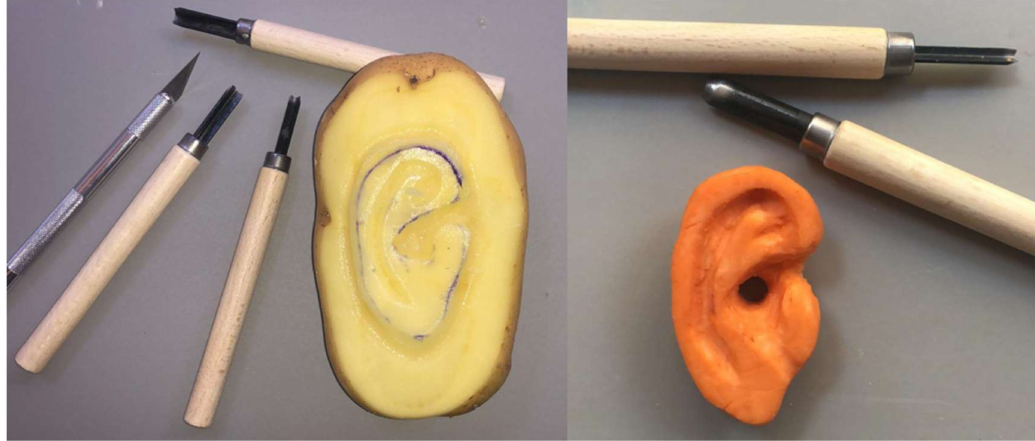
Figure 2. Simulation of ear reconstruction with